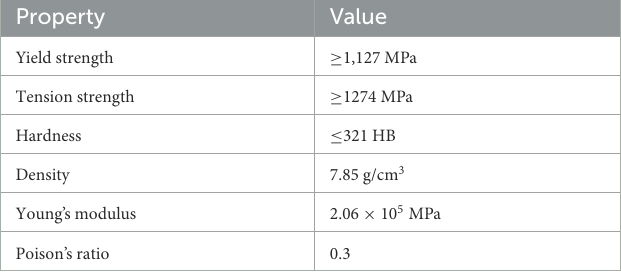
TABLE 2 Mechanical property of the spring steel,